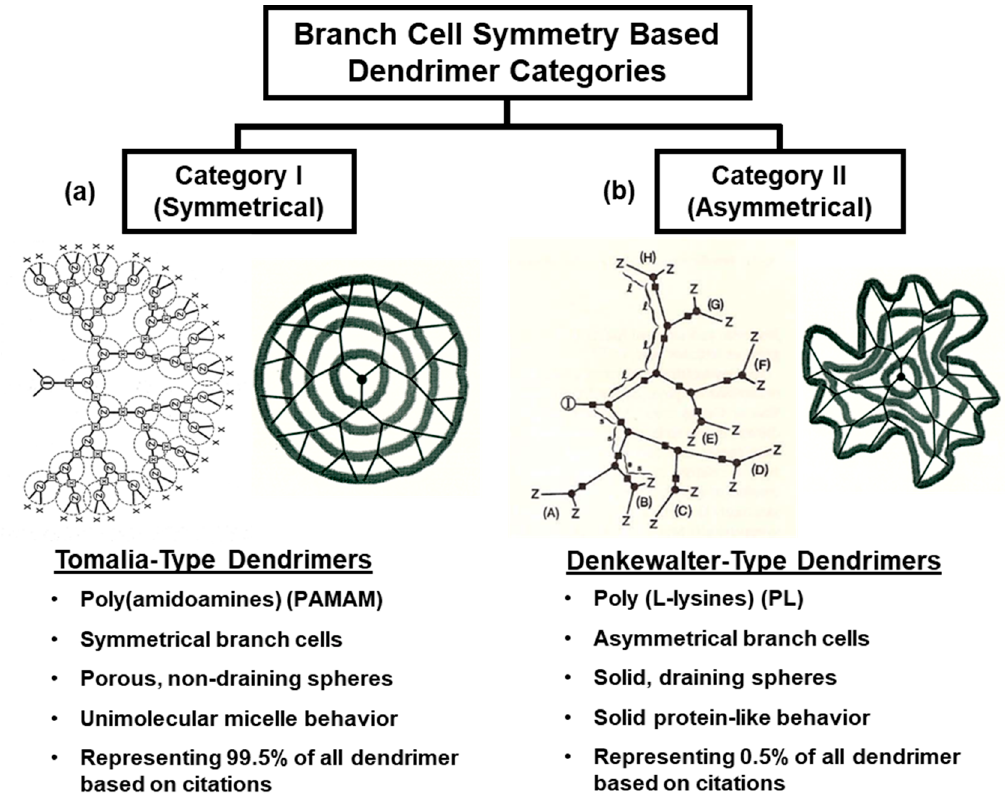
Figure 7. Classification of first divergently synthesized dendrimers ( a ) Denkewalter poly(L-lysine) (PL) dense draining spheroids; ( b ) Tomalia, poly(amidoamine) (PAMAM) hollow, non-draining spheroids (1984).